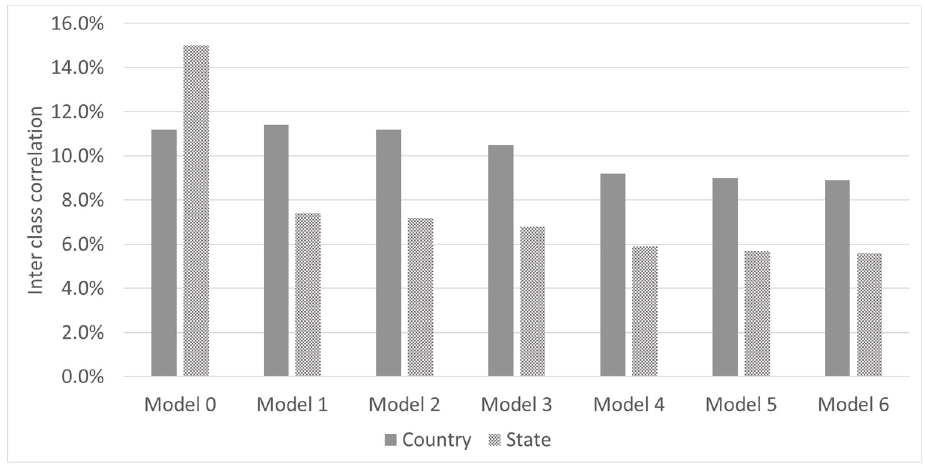
Figure 2. Inter class correlation by models. Model 0: Null model only variance level cluster; Model 1: adds national level variables; Model 2: adds state (subnational) level variables; Model 3: adds household socioeconomic variables; Model 4: adds child and mother characteristics; Model 5: adds feeding variables; Model 6: adds child health variables.